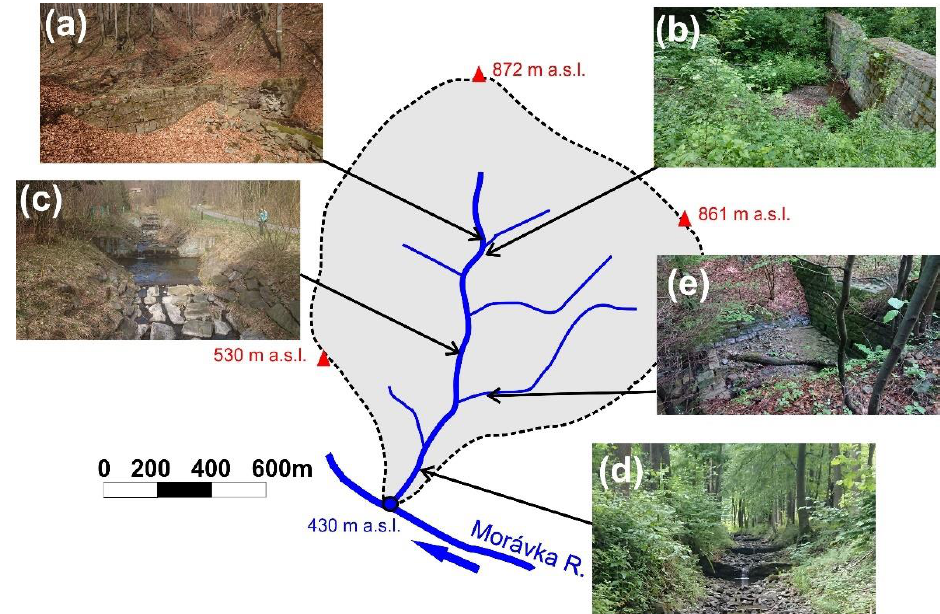
Figure 5. Examples of the torrent control works in the Vysutý catchment (catchment area is 2.47 km 2 ): ( a ) remnants of the old retention check dam, ( b ) ca. 2.5 m-tall new retention check dam built in 2011, ( c ) ca. 1.0–1.5 m-tall grade control structures, ( d ) low bed sills in the downstream part, ( e ) 3 m-tall retention check dam in the small recipient.